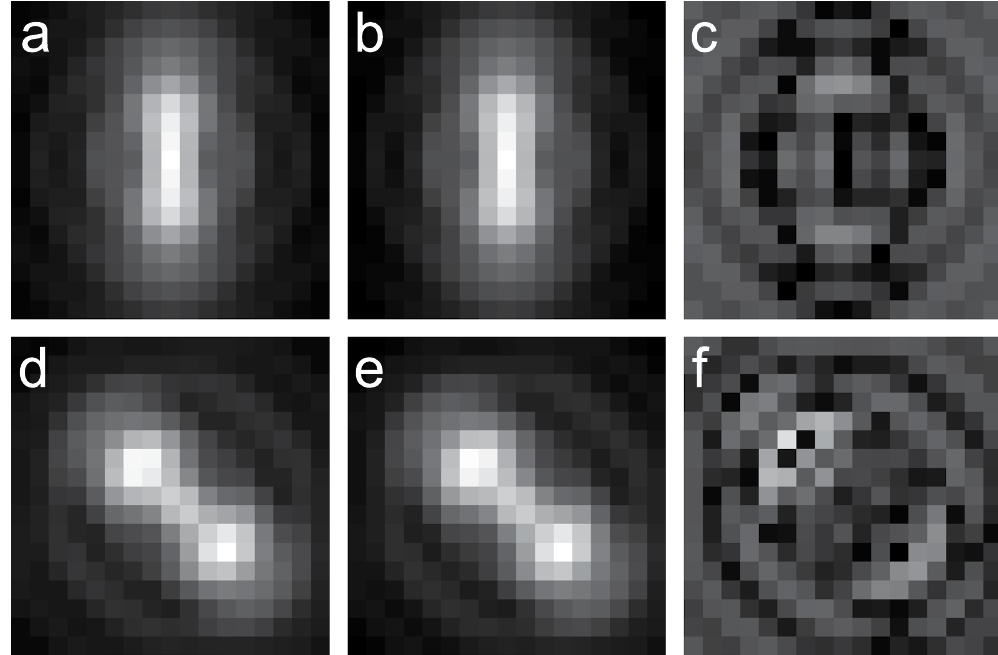
Figure 2. Analytical PSFs and their spline representations for the astigmatic PSF and saddle-point PSF. ( a ) Astigmatic PSF at z = − 420 nm. ( b ) Cubic spline representation of ( a ). ( c ) Difference between ( a ) and ( b ) multiplied by 100. ( d ) Saddle-point PSF at z = − 420 nm. ( e ) Cubic spline representation of ( d ). ( f ) Difference between ( d ) and ( e ) multiplied by